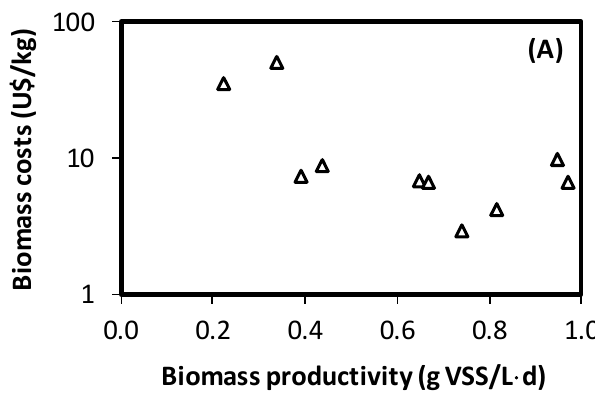
Table 3. PHB average productivity for the operation of SBR.